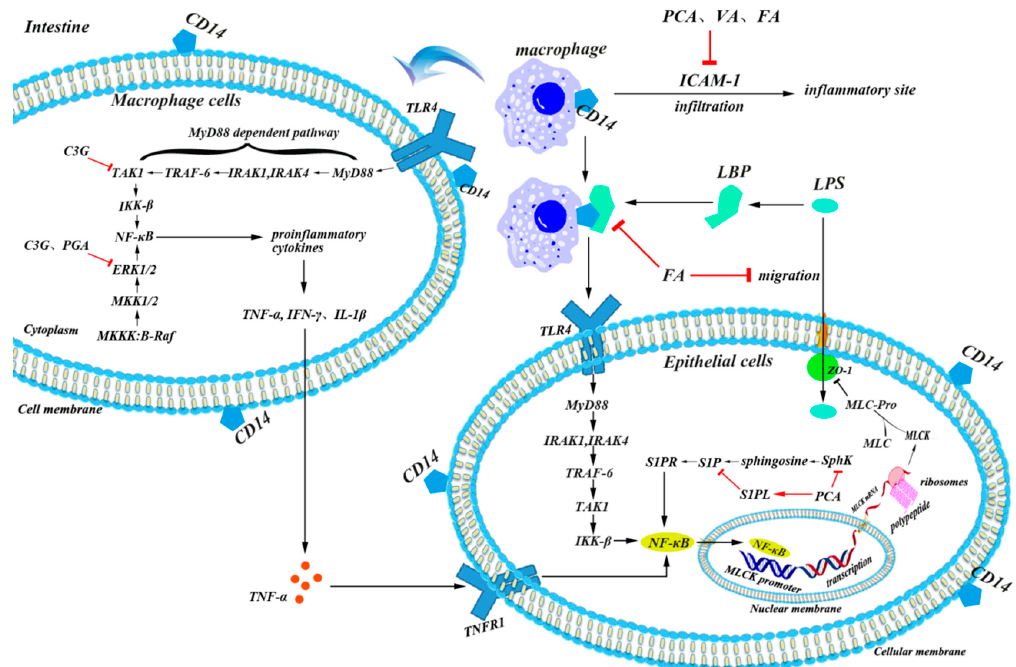
Figure 4. Potential mechanisms of C3G&C3G-Ms in attenuating intestinal inflammation. C3G and its